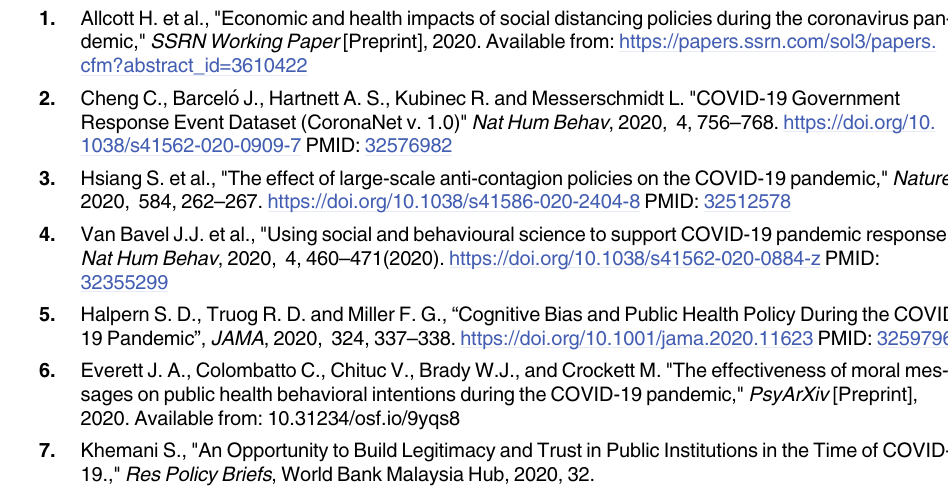
S3 Fig. Self-reported compliance. Per the survey, not including incongruent